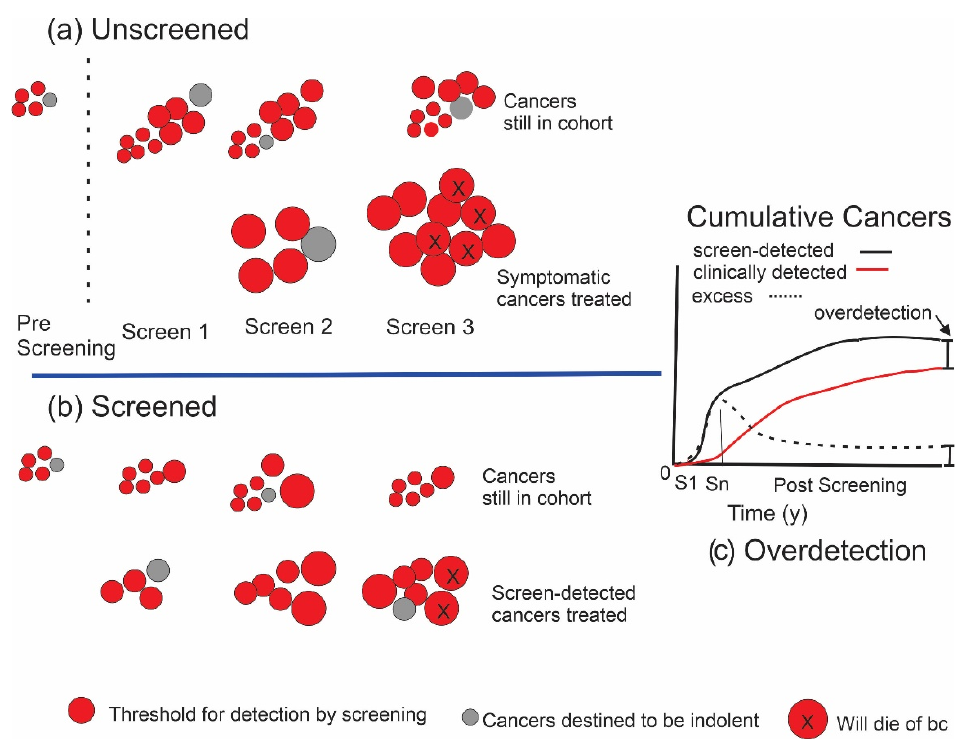
Figure 2. Initiation and growth of breast cancers in the presence of cancers with limited malignant potential. ( a ) An unscreened population. Grey discs indicate cancers that are destined not to be lethal. ( b ) The effect of screening. Lower row indicates cancers that have been detected and treated, while upper row indicates cancers in the cohort that have not yet been detected. ( c ) Overdetection. After screening ends at Sn, the initial excess of cancers in the screened grouped will not be completely eliminated over time.